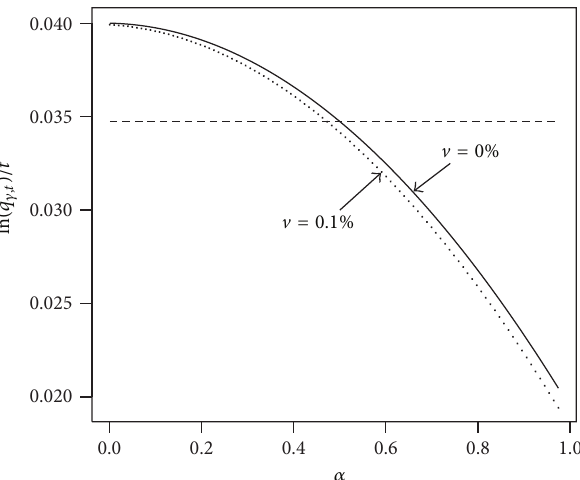
Figure 2: The plot shows ln (𝑞 𝛾,𝑡 )/𝑡 as a function of 𝛼 in our example, where 𝑡 = 40 . Parameters are 𝑟 = 4 %, 𝜇 = 8 %, 𝜎 = 20 %, and 𝛾 = 10 %. We compare ] = 0 % (solid) with ] = 0.1 % (dotted). The horizontal dotted line indicates the value of ln (𝑞 0.1,40 )/40 when 𝛼 = 50 % and ] = 0